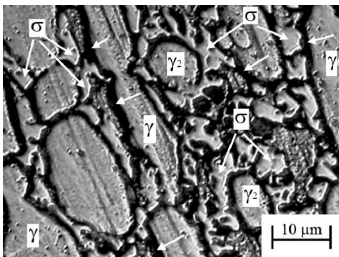
Figure 12. SD-A aged at 950 °C for 45 minutes, after DL-EPR test at room temperature.